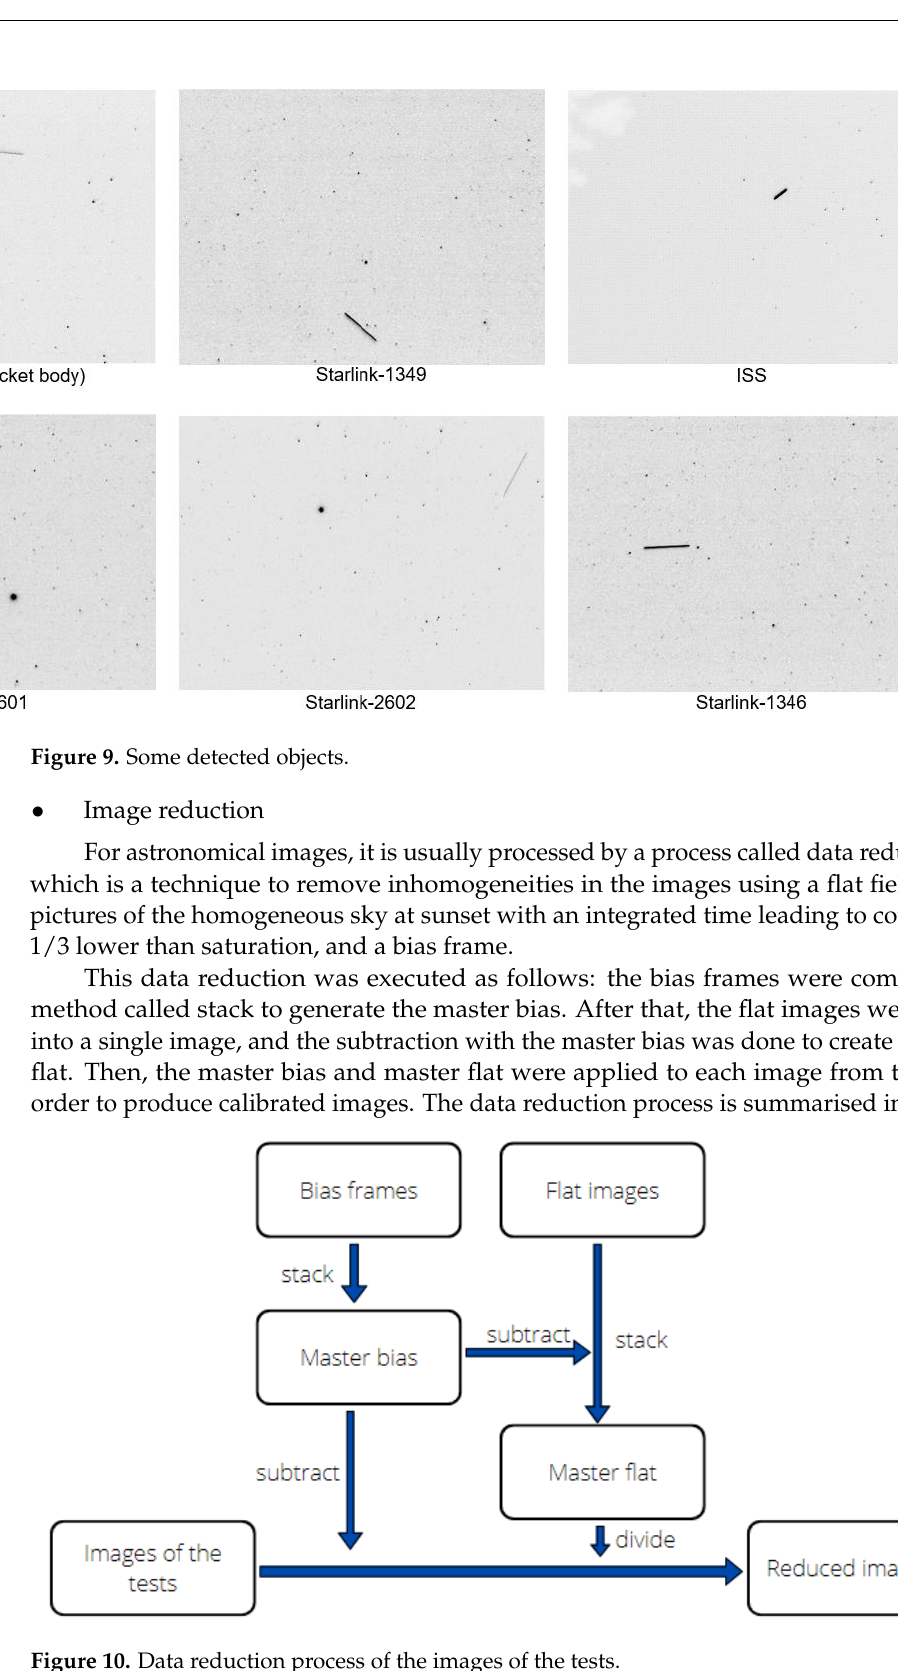
Figure 10. Data reduction process of the images of the tests.